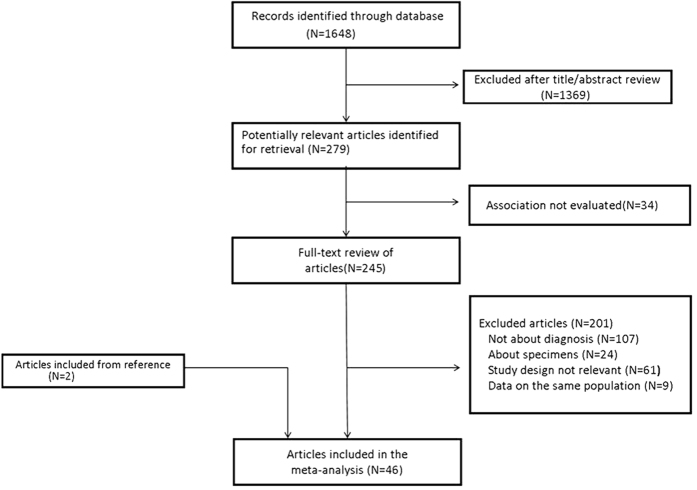
Literature search.